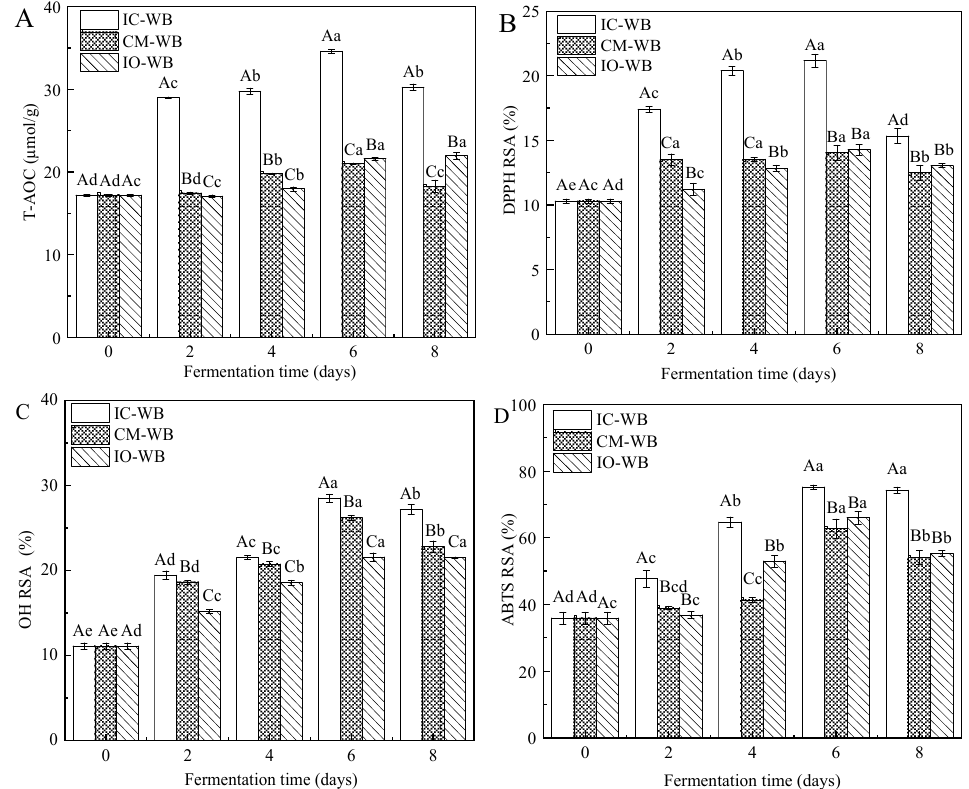
Figure 4. In vitro antioxidant activities of fermented wheat brans characterized by ( A ) total antioxidant capacity (T-AOC), ( B ) DPPH radical scavenging ability (DPPH RSA), ( C ) hydroxyl radical scavenging ability (OH RSA), and ( D ) ABTS radical scavenging ability (ABTS RSA). Different lowercase letters indicate significant differences at p < 0.05 in terms of fermentation time. Different capital letters indicate significant differences at p < 0.05 in terms of microorganisms. IC-WB, Isaria cicadae Miq. fermented wheat bran; CM-WB, Cordyceps militaris fermented wheat bran; IO-WB, Inonotus obliquus fermented wheat bran.